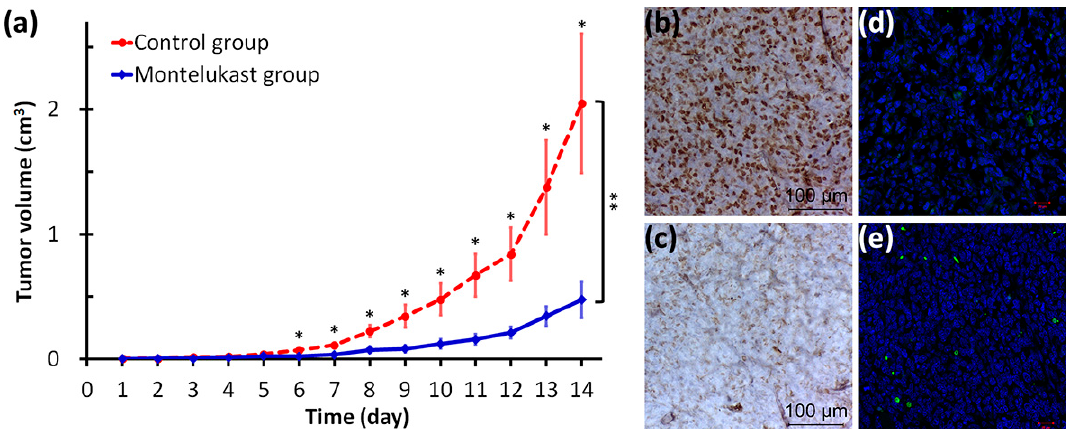
Figure 6. In vivo study showing the anticancer effect of montelukast. The C57BL/6JNarl (B6) mice were given either water (control group) or 100 μ g of montelukast in water (treatment group) via tube feeding daily from day − 3 to day 13. Each mouse was injected with 500,000 Lewis lung carcinoma (LLC) cells subcutaneously on day 0. The mice were sacrificed on day 14 and the tumor specimens were sent for a pathological exam. ( a ) The tumor volume was shown in mean (±standard error of mean) for each group on each day (from day 1 to day 14) and plotted. * p < 0.05, while comparing the tumor volumes in both groups on the same day. ** We adapted a mixed effect model based on the tumor volume with the effects of group, time, and their interaction, while taking into account the repeated observations of study mice. All three effects showed significantly different tumor growth [group (montelukast group vs. control group), p = 0.0369; time (in days), p < 0.0001; their interaction (growth rates of montelukast group vs. control group), p < 0.0001]; ( b , c ) immunohistochemical staining showed a markedly decreased Ki-67 expression in the tumor specimens from the montelukast group ( c ) compared to the control group ( b ); ( d , e ) confocal microscopy of the terminal deoxynucleotidyl transferase dUTP nick end labeling (TUNEL) assay showed a markedly increased number of TUNEL-positive cells in the tumor specimens from the montelukast group ( e ) compared to the control group ( d ).